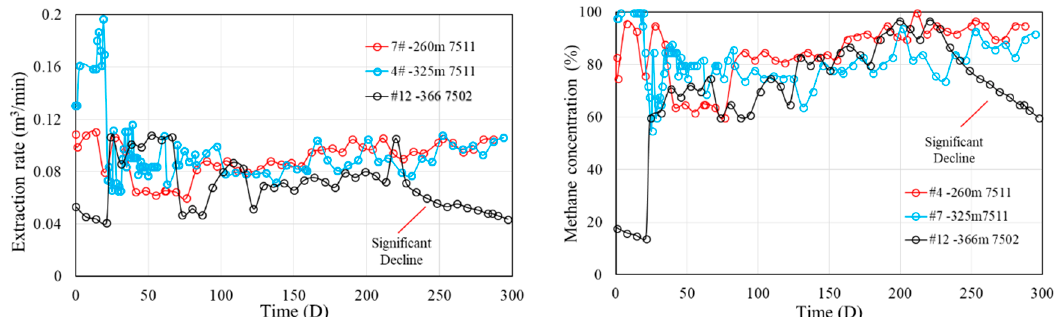
Figure 8. Variations of methane concentration and methane extraction rate with time.